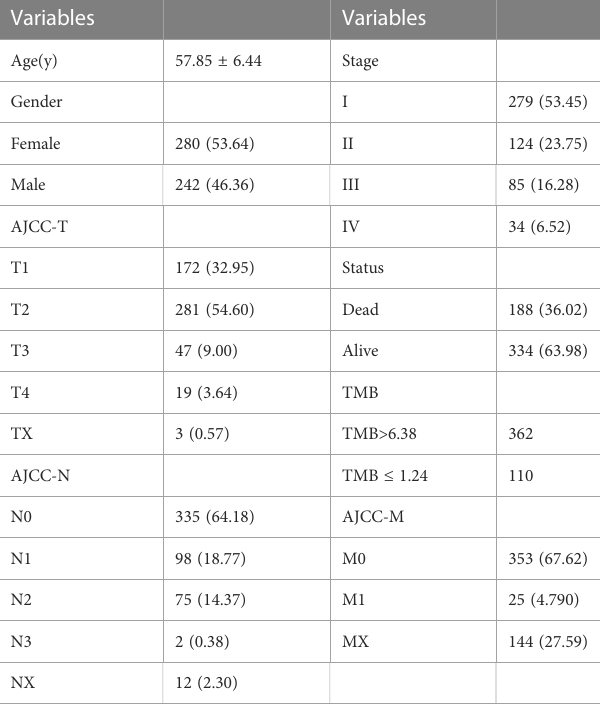
TABLE 1 Clinical information of 522 LUAD patients.